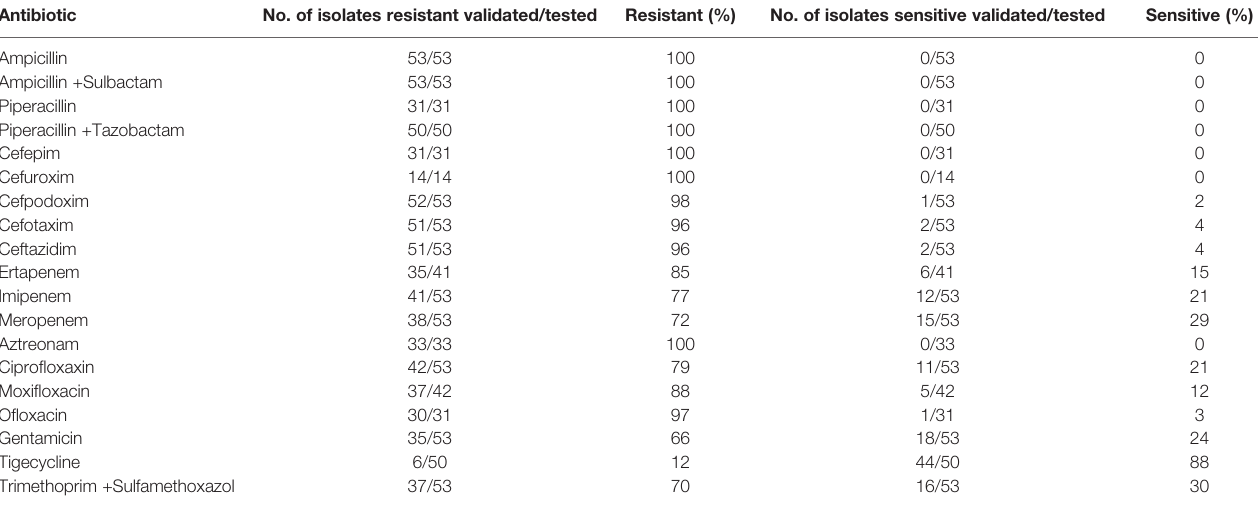
TABLE 2 | Results of the Antimicrobial susceptibility testing of 53 Carbapenemase-producing Citrobacter spp. isolates as determined by VITEK-2 and according to EUCAST breakpoints. Antibiotic No. of isolates resistant